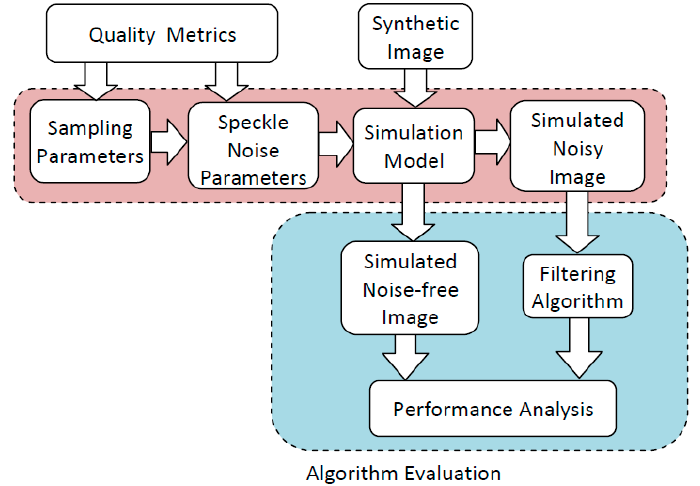
Figure 8. Application of the proposed local binary patterns (LBP) features in the evaluation of filtering algorithms.